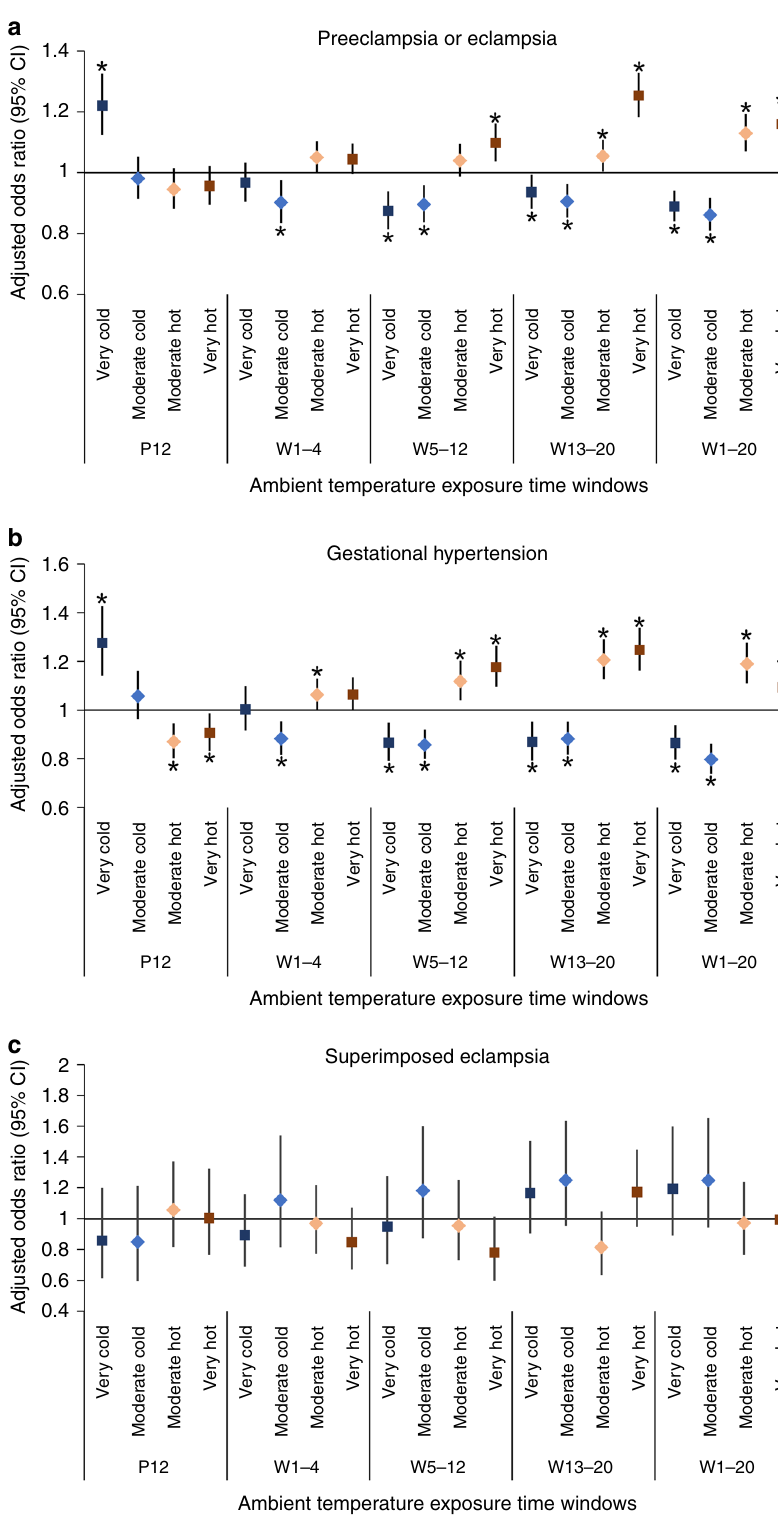
Fig. 1 Adjusted odds ratios of HDP for extreme temperatures by pregnancy periods. The models were adjusted for the hospital level, antenatal care visits, marital status, region, mother ’ s education, mother ’ s age, parity, number of fetuses, elevation, humidity, and air pollution exposure. a Preeclampsia or eclampsia; b gestational hypertension; c superimposed preeclampsia. Data are presented as aORs with 95% con fi dence intervals. Black error bars correspond to 95% con fi dence intervals, center for the error bars correspond to points estimate of aORs. Black stars denote p < 0.05. PC preconception, W weeks postconception. Source data are provided as a Source Data fi